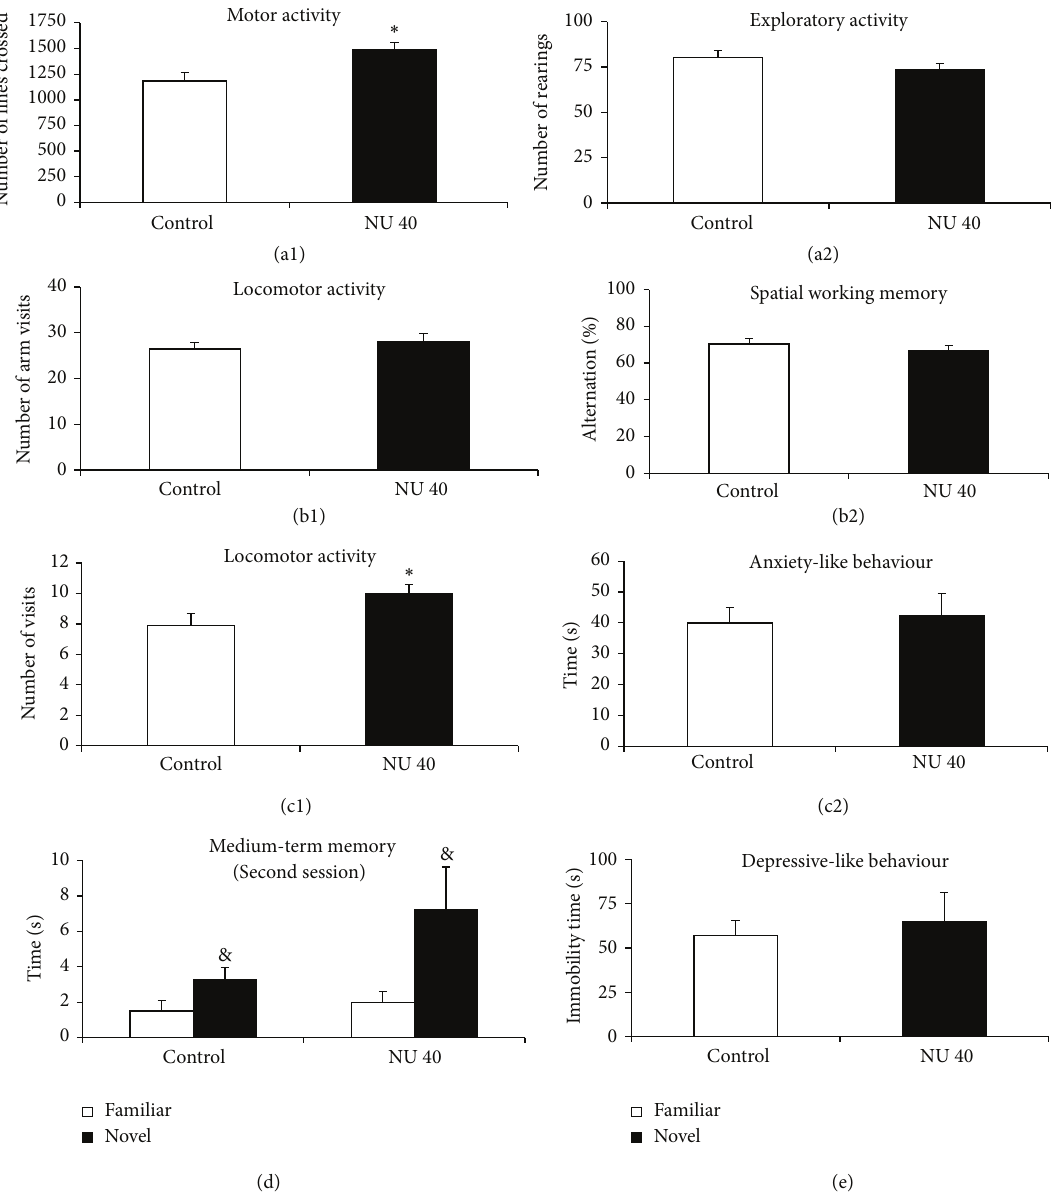
Figure 6: Total activity, spatial working memory, anxiety-like behaviour, medium-term memory, and depressive-like behaviour of female rats exposed to NU at 40 mg ⋅ L −1 from birth for 9 months. (a1) shows the number of lines crossed, reflecting locomotor activity. The number of rearings is presented in (a2) and reflects exploratory activity. (b1) shows the number of arm entries in the Y-maze and reflects locomotor activity. (b2) shows the alternation between arms, expressed as a percentage (%), in the Y-maze and reflects spatial working memory. (c1) shows the number of visits to the closed arms of the elevated plus maze and reflects locomotor activity. (c2) shows the time spent, expressed in seconds (s), in the closed arms of the elevated plus maze and reflects anxiety level. (d) shows the time spent on the familiar or new objects during the second session expressed in seconds (s) and reflects medium-term memory. (e) shows the time of immobility expressed in seconds (s) and reflects the depression level. Results are expressed as mean ± SEM for control and exposed animals to 40 mg ⋅ L −1 NU; 𝑛 = 12 /group; NU: natural uranium. ∗ 𝑝 < 0.05 , significant difference from control. & 𝑝 < 0.05 , significant difference from familiar